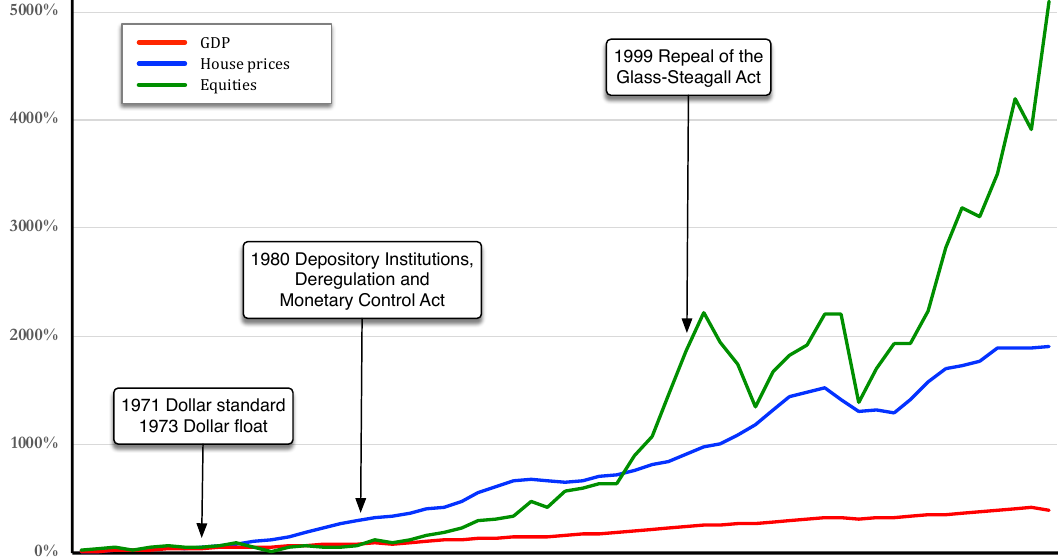
Figure 11. Comparison of percentage change in asset prices (residential house prices and S&P 500 equities vs. GDP, United